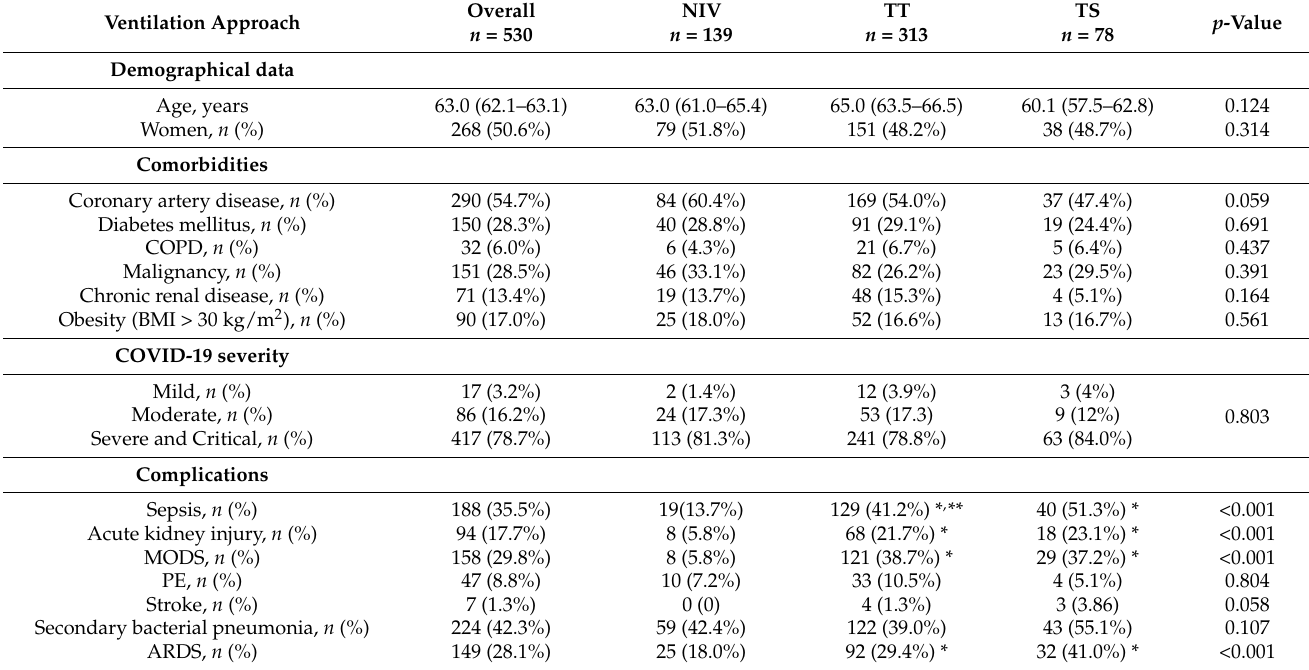
Table 1. Demographic characteristics, comorbidities, COVID-19 severity, and complications. Data are presented as mean and 95% confidence intervals, median interquartile ranges, or numbers and percentages as appropriate. Abbreviations: NIV (non-invasive ventilation); TT (invasive mechanical ventilation with tracheal tube); TS (invasive mechanical ventilation with tracheostomy); COPD (chronic obstructive pulmonary disease); ARDS (acute respiratory distress syndrome); BMI (body mass index); MODS (multiple organ dysfunction syndrome); PE (pulmonary